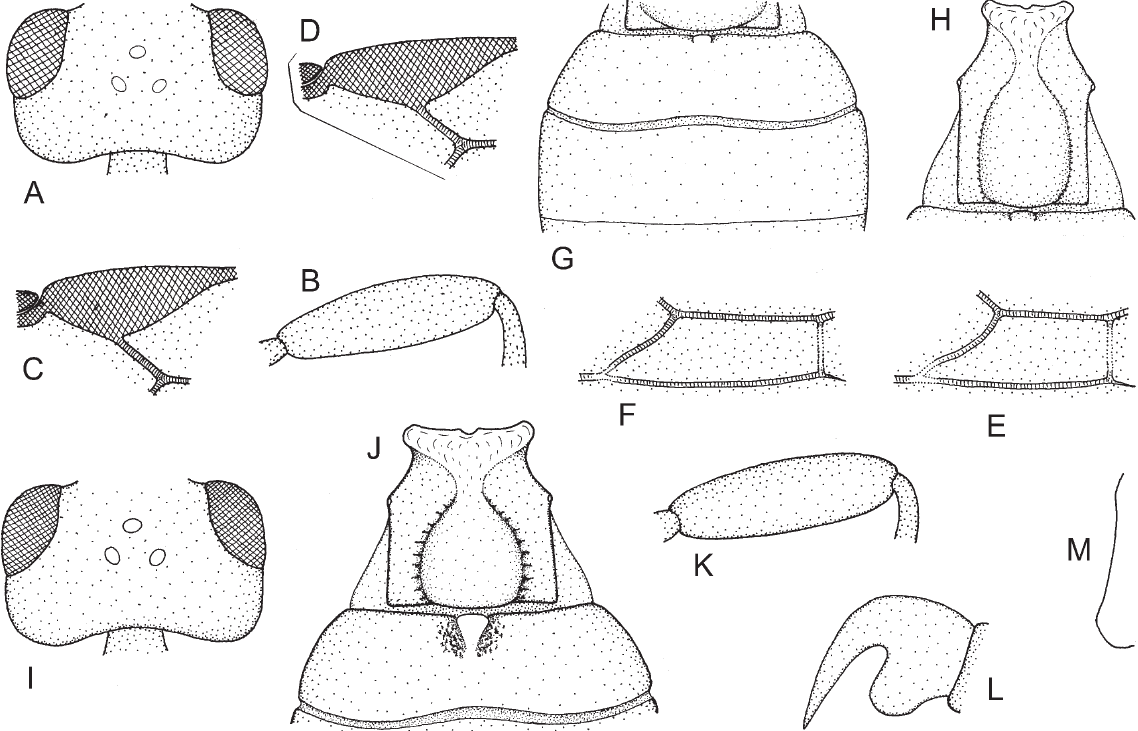
Fig. 43. — A-H . Bracon ( Glabrobracon ) praecox Wesmael, 1838 (A-G: ♀, H: ♂). A . Head in dorsal view. B . Hind femur. C-D . Pterostigma and r of right forewing. E-F . Second submarginal cell of right forewing. G . Tergites 2-3. H . First tergite. — I-M . Bracon ( Glabrobracon ) bruchivoru s Muesebeck, 1963, ♀ / ♂. I . Head in dorsal view. J . Tergites 1-2. K . Hind femur. L . Claw. M .